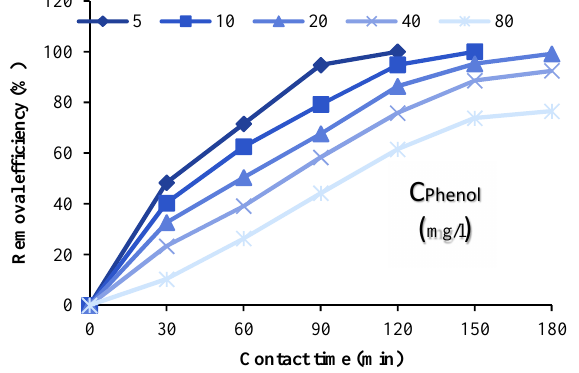
Figure 8. The effect of various concentrations of sodium chloride on the removal of phenol in the UV/ZnO process (pH = 3, phenol = 40 mg/l, and radiation intensity = 3950 µw/cm 2 )